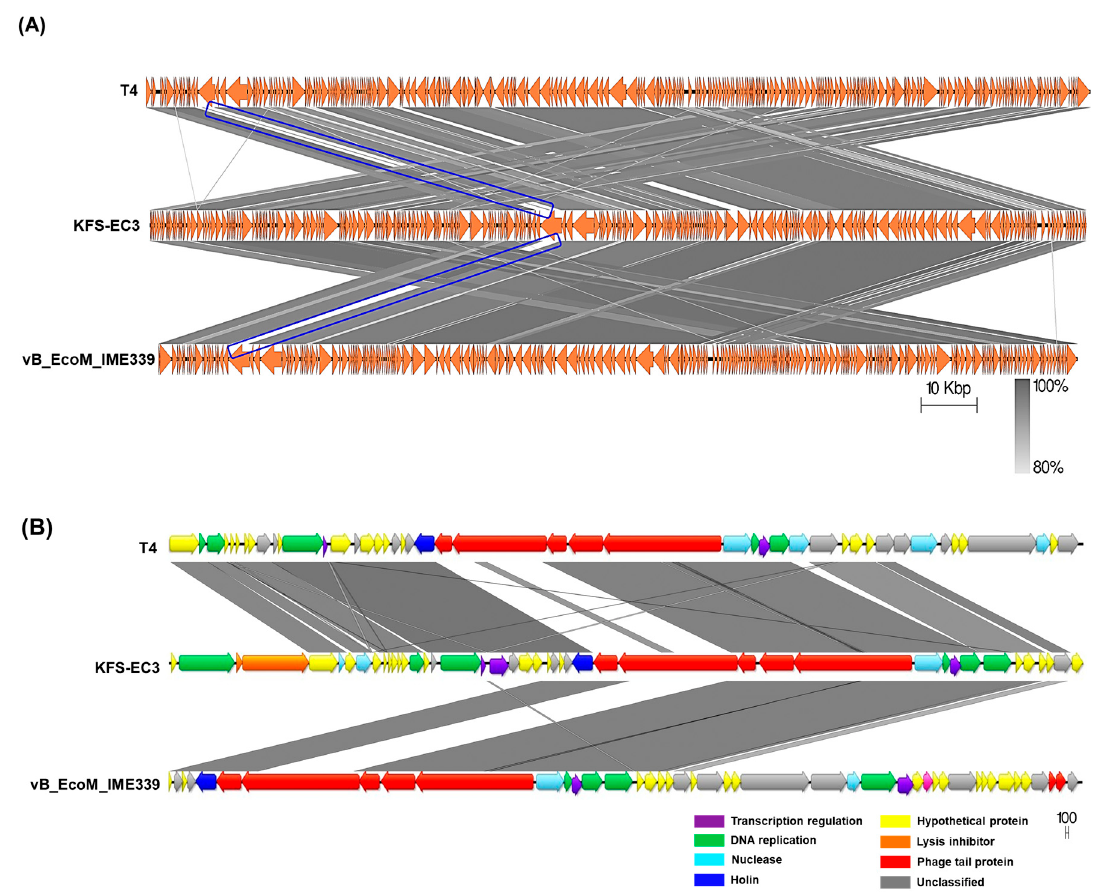
Figure 8. Genomic comparative analysis of KFS-EC3 (middle), Escherichia phage T4 (top), and E . coli phage vB_EcoM_IME339 (bottom). Gene clusters whose translated products shared low similarity were indicated using blue boxes. ( A ) Complete genome of the three phages visualized using Easyfig. ( B ) Boxed gene clusters at high magnification. Homologous regions were indicated by gray shading in figures.